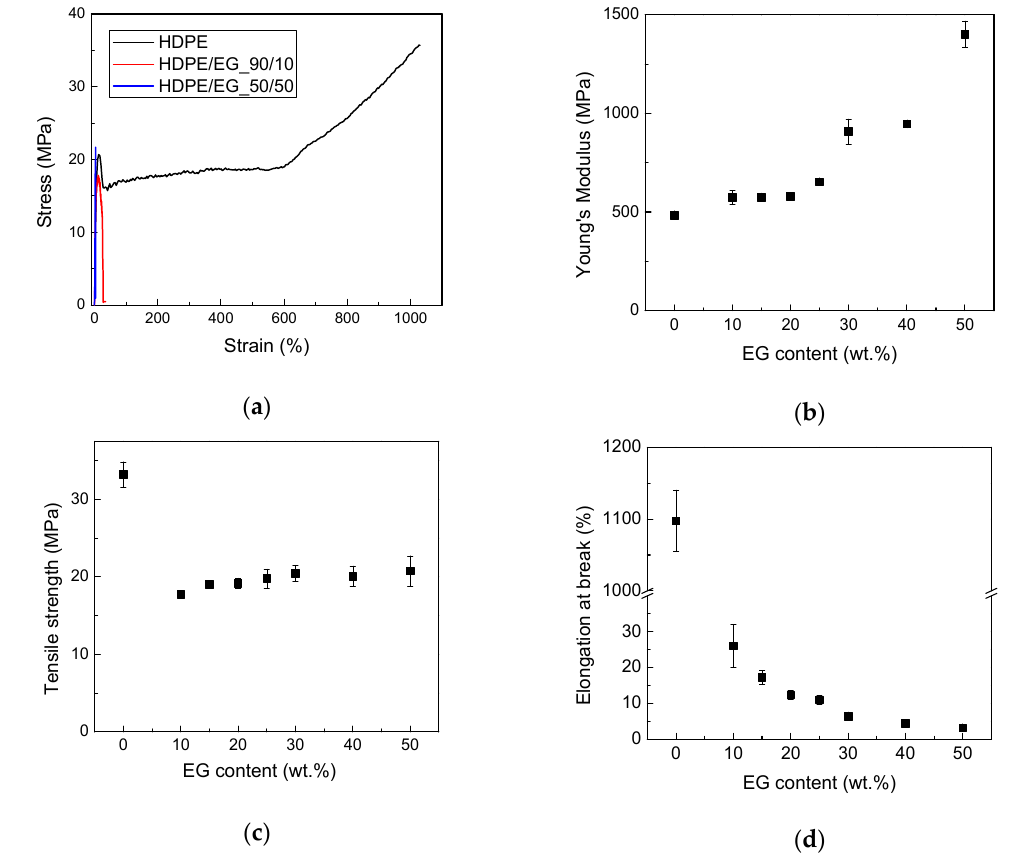
Figure 5. ( a ) stress-strain curve of HDPE and composites contain 10 and 50 wt.% of EG, ( b ) Young’s modulus HDPE and composites, ( c ) Tensile strength HDPE and composites, and ( d ) elongation at break HDPE and composites.